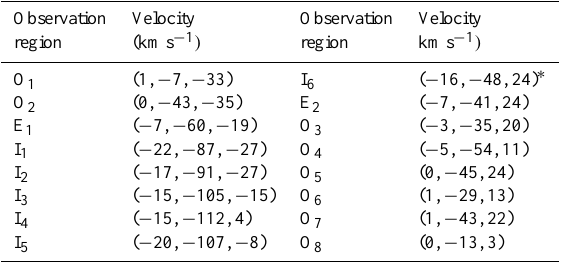
Table 1. High-time-resolution E × B drift velocity in LMN coor- dinate system, calculated from parameters observed by EFW and FGM instruments on Cluster 1. Note that these values are calcu- lated assuming that E · B = 0.